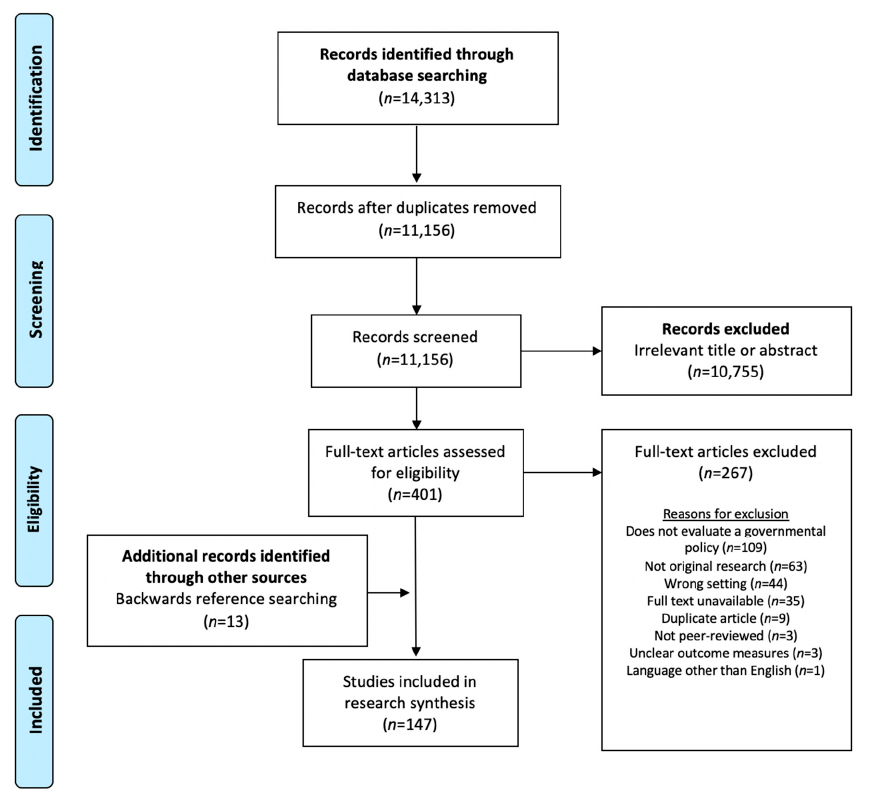
Figure 1. Preferred Reporting Items for Systematic Reviews and Meta-Analyses (PRISMA) Flow Diagram.